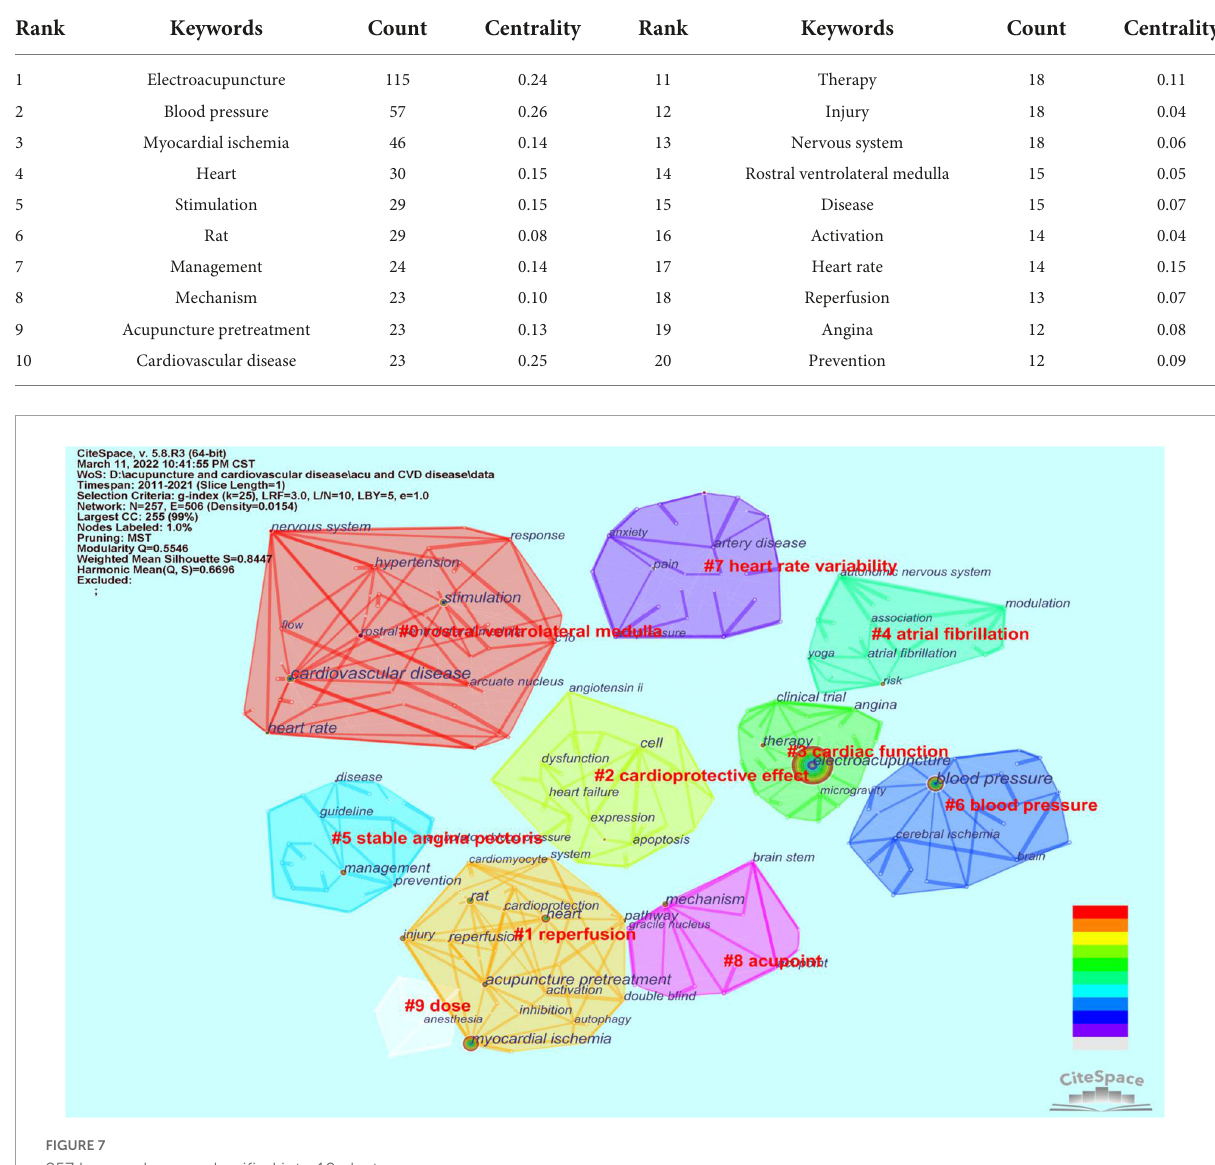
FIGURE7 257 keywords were classified into 10